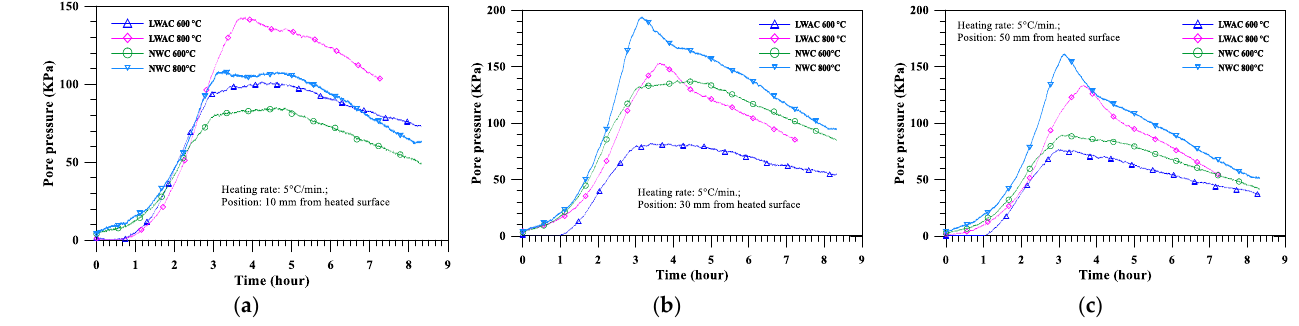
Figure 16. Effect of the target temperature on the pore pressure of oven-dried specimens performed at a heating rate of 5 °C/min: ( a ) 10; ( b ) 30; ( c ) 50 mm depths. at a heating rate of 5 ◦ C/min: ( a ) 10; ( b ) 30; ( c ) 50 mm depths.